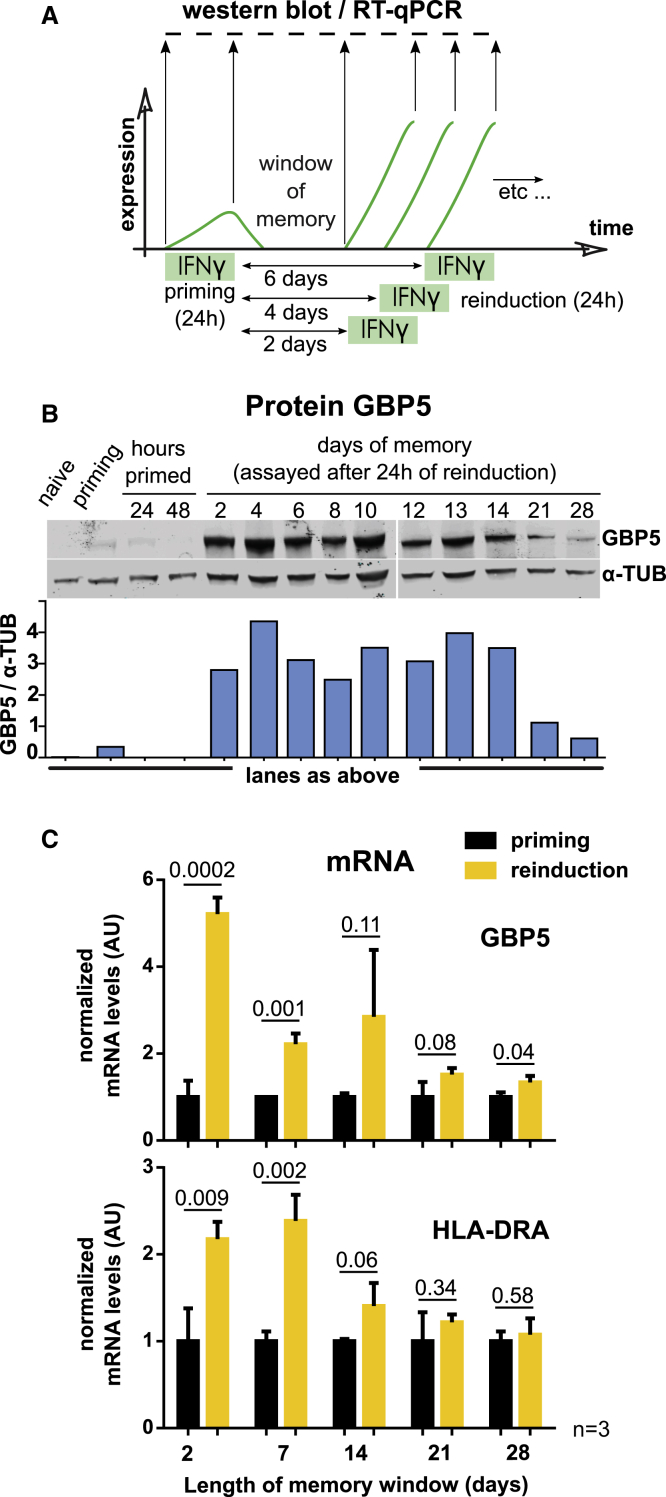
Memory of Prior IFNγ Induction Is Reversible but Persists for up to 14 Days in Continuously Cycling Cells(A) Scheme outlining the experiment to determine the duration of IFNγ-mediated transcriptional memory.(B) Cells subjected to the IFNγ treatment regimen outlined in (A) were processed for western blotting and probed for GBP5 protein expression. α-TUB, loading control.(C) Cells as in (B) but processed for RT-qPCR of GBP5 and HLA-DRA mRNA. Expression levels were normalized to ACTB and internally to cells after priming. Error bars, SD; n = 3 biological replicates; numbers represent the p values.